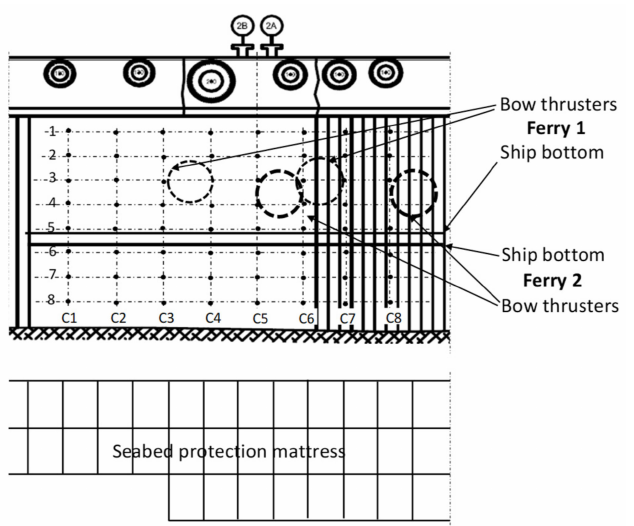
Figure 1. Layout of measuring sensors and projection of the bow thruster openings of Ferry 1 and Ferry 2 moored at the